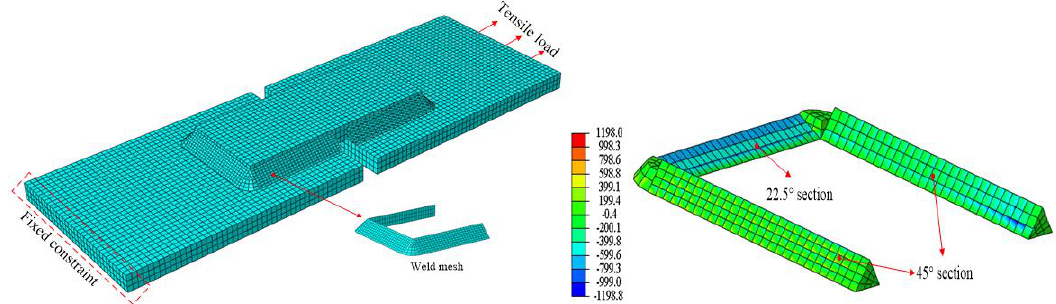
Figure 13. FEM and nodal force distribution of the U−shaped fillet welded specimen.